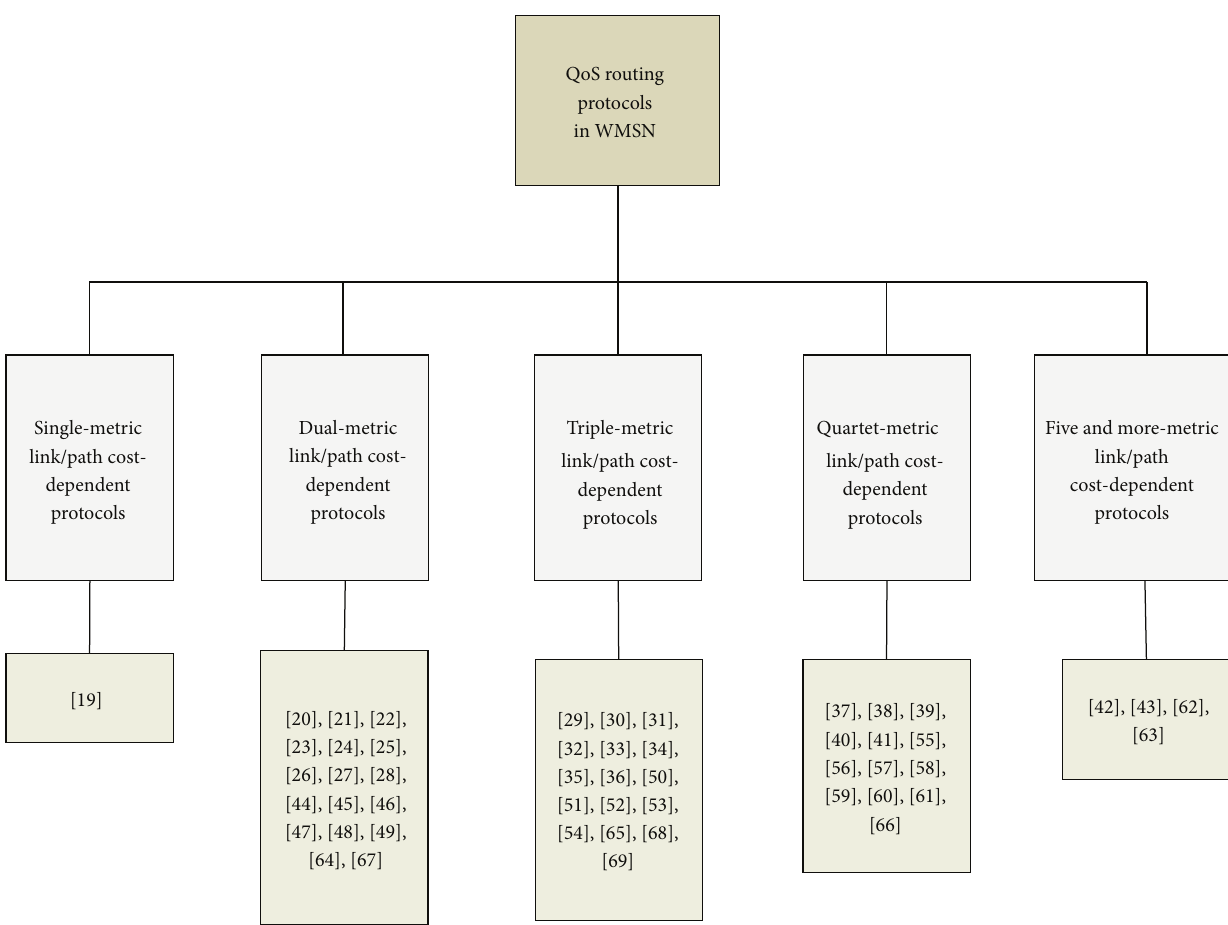
Figure 1: Metrics-aware classification of QoS routing protocols for